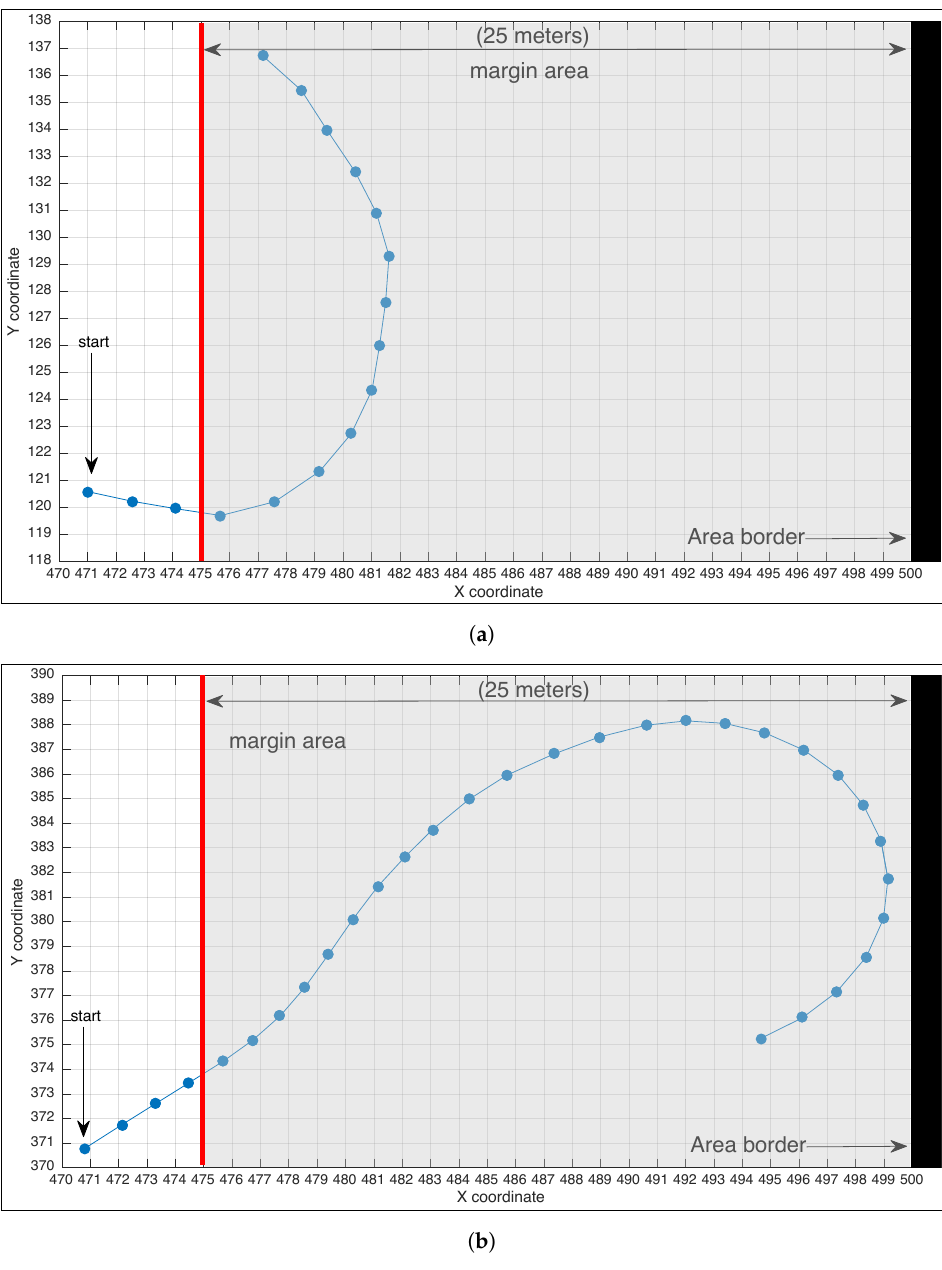
Figure 7. Samples of the paths around the boundary using ( a ) GM; ( b )